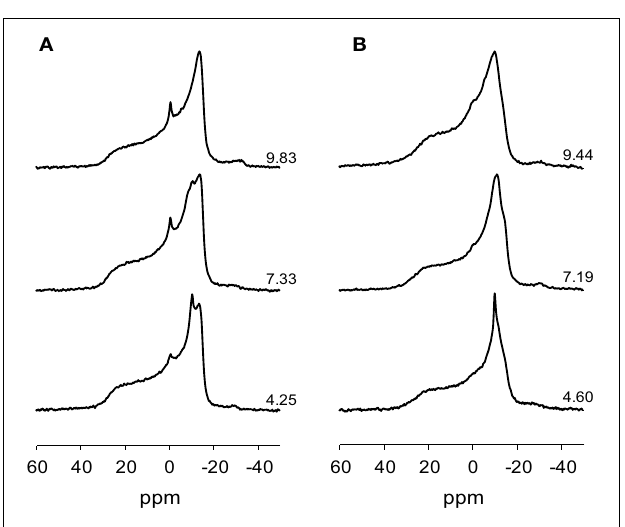
FIGURE 1 | (A) differential scanning calorimetry data for 5mol% of indicated phospholipid in DEPE. Bottom curve is DEPE control. Shown is the third upscan of each experiment. (B) Means of theT HII from three